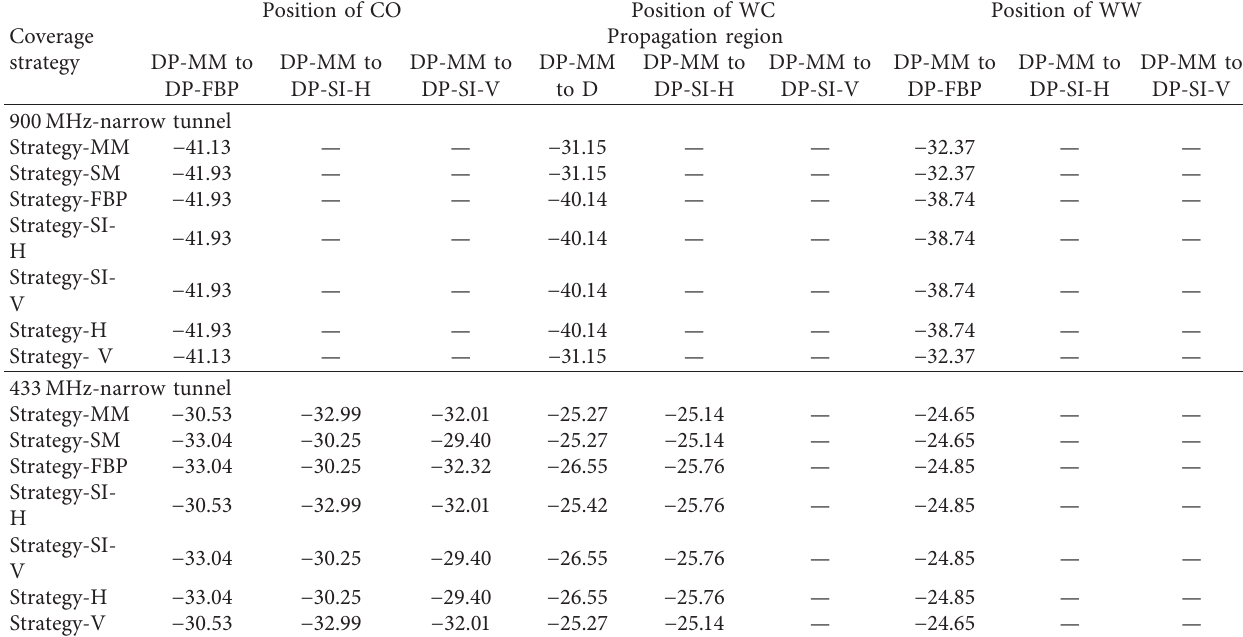
Table 10: Average field power in different propagation regions (in dBm): coverage in the narrow tunnel. Coverage